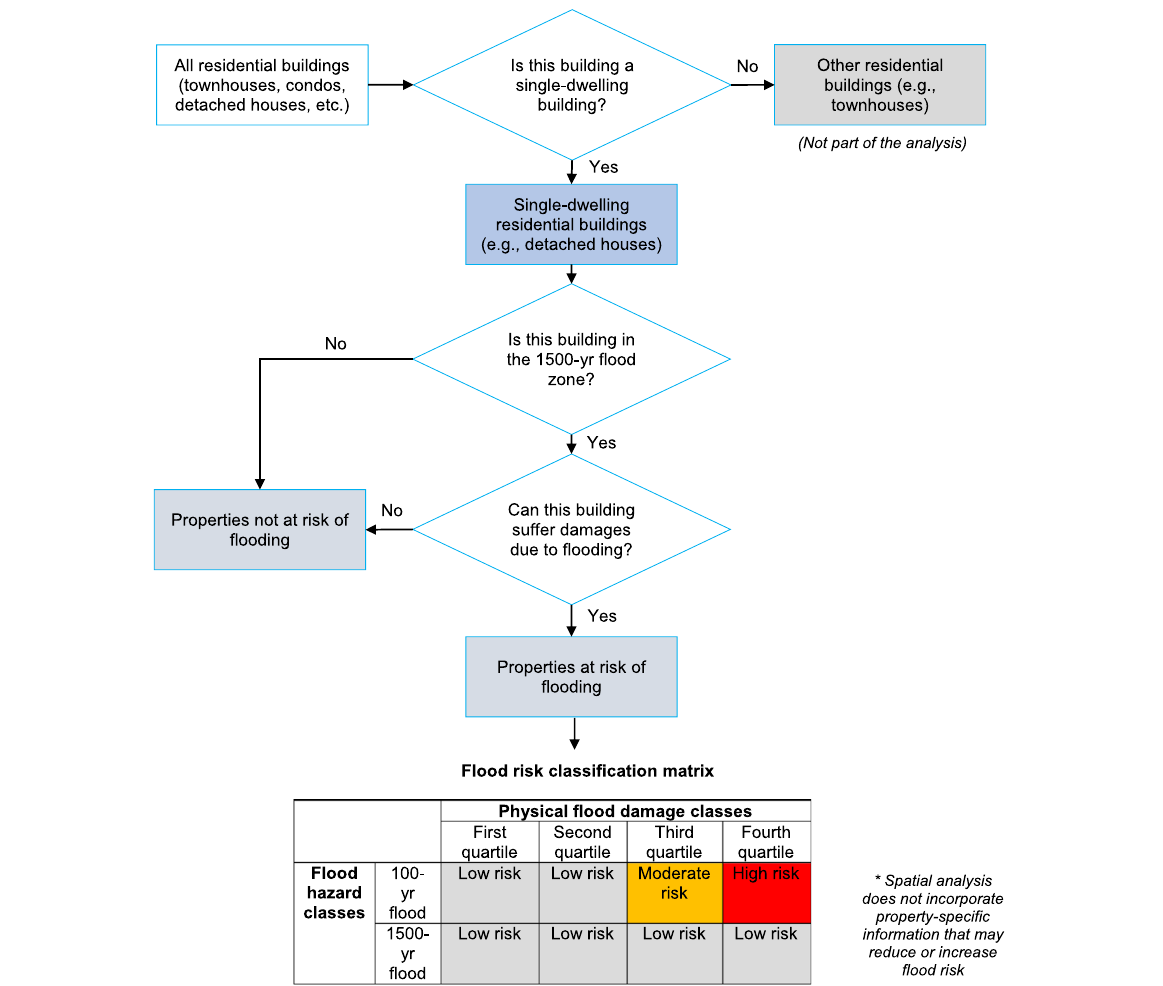
Fig. 6 Classification of at risk and high risk residential properties. Brewer and Pickle (2002) and Albano et al. (2017) served as guidance for this